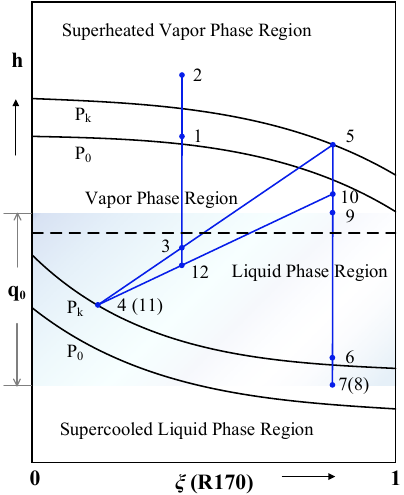
Figure 3. Concentration-enthalpy diagram of the